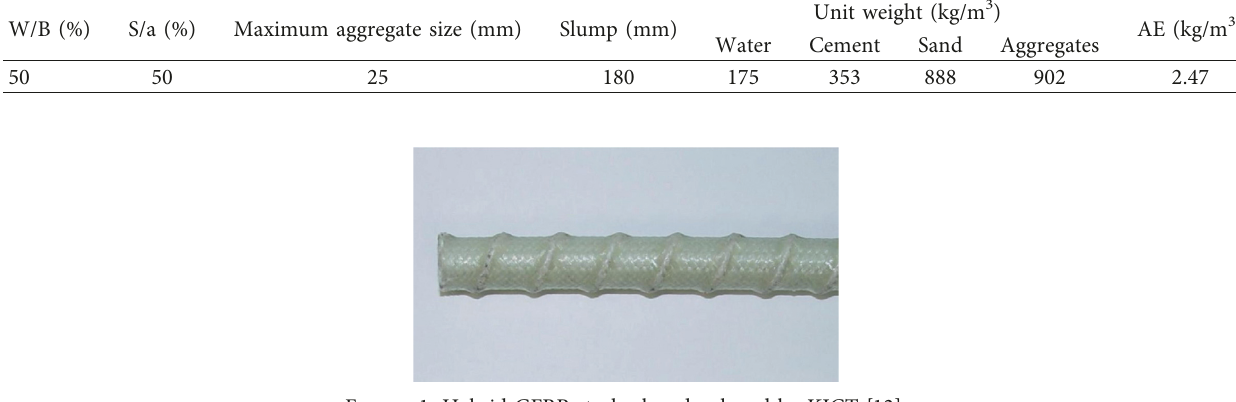
Figure 1: Hybrid GFRP-steel rebar developed by KICT [12].